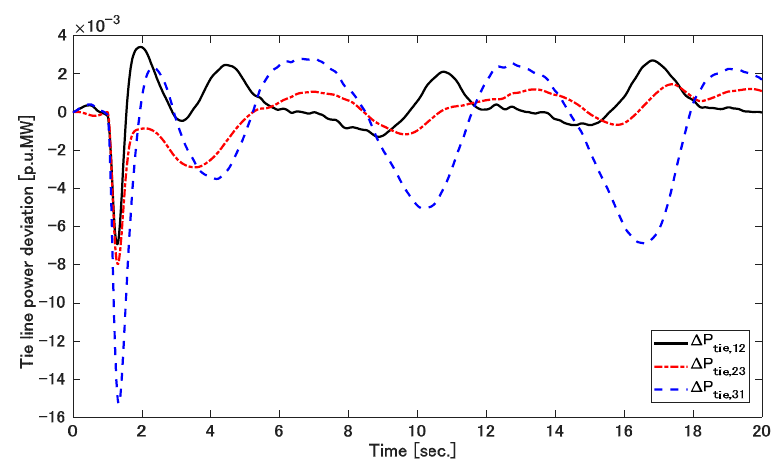
Figure 15. Tie-line power deviation of three-area power system with a wind plant.